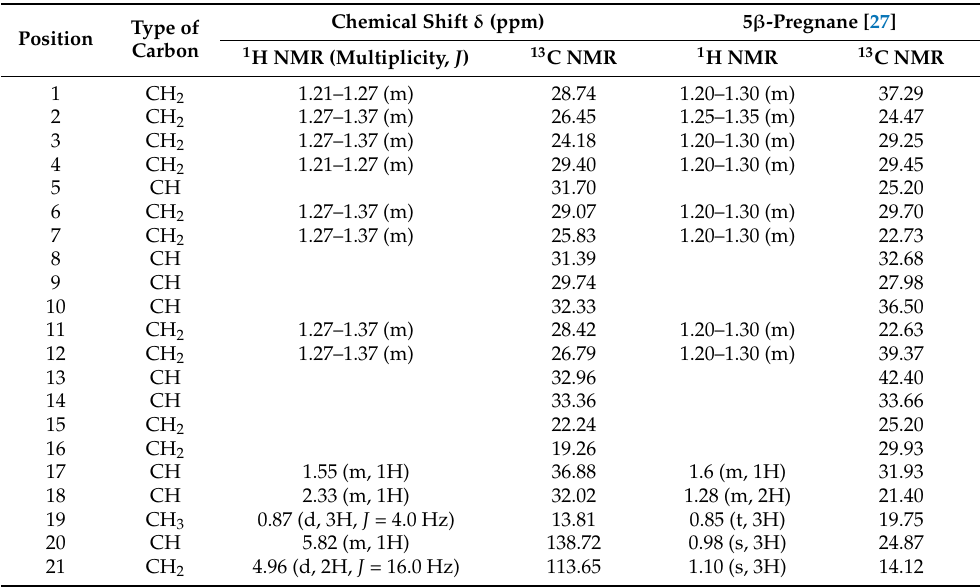
Table 2. 1 H- and 13 C NMR Spectral Data Assignment of Compound 2 Isolated from C. sexangularis